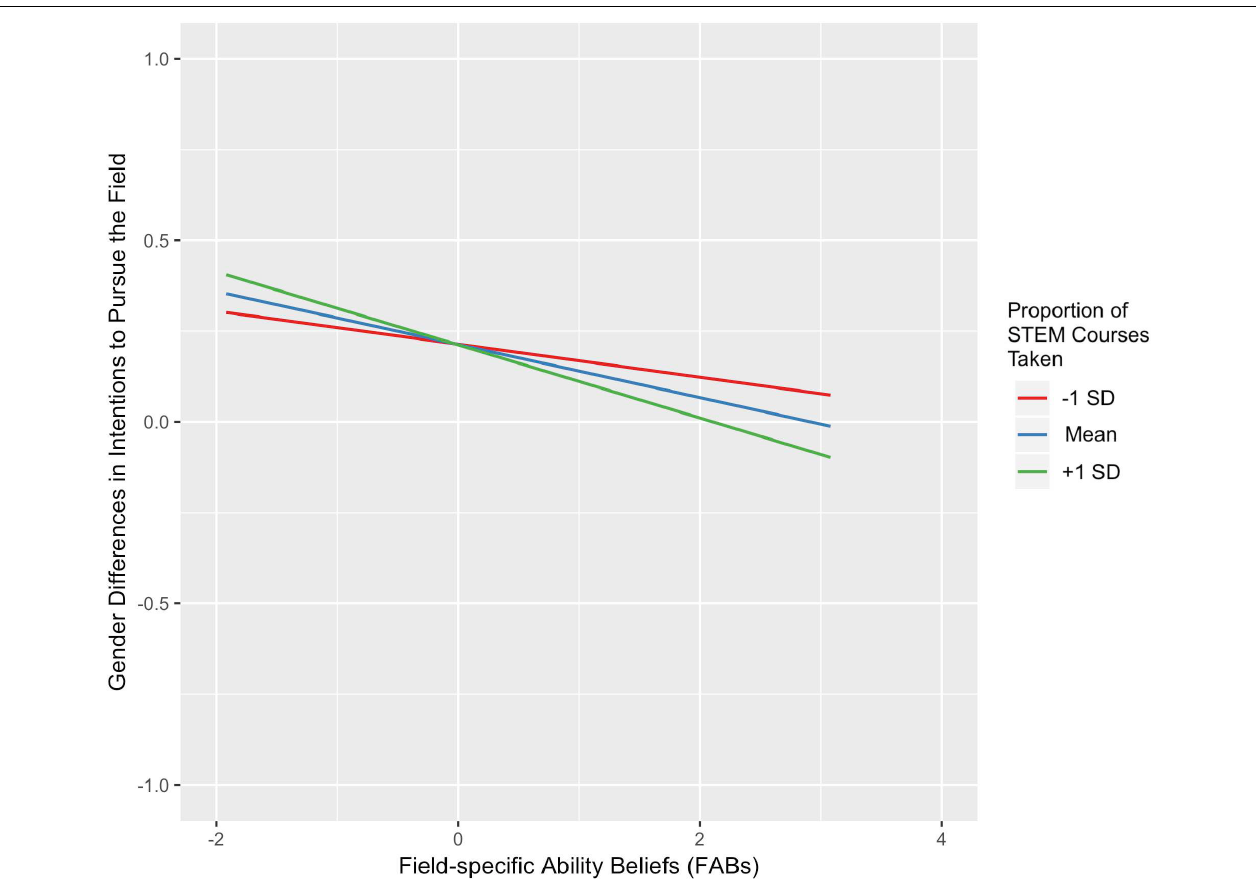
FIGURE 3 | The relationship between beliefs about the necessity of brilliance for success in a field and the difference between mean female and male students’ intent to pursue that field. Higher values on intentions indicates higher intentions among female as compared to male subjects. The green and red lines represent the predicted slope for students 1 standard deviation above and below the mean in proportion of pSTEM courses taken, respectively; the blue line depicts the predicted slope for students at the mean of proportion of pSTEM courses taken. FABs is